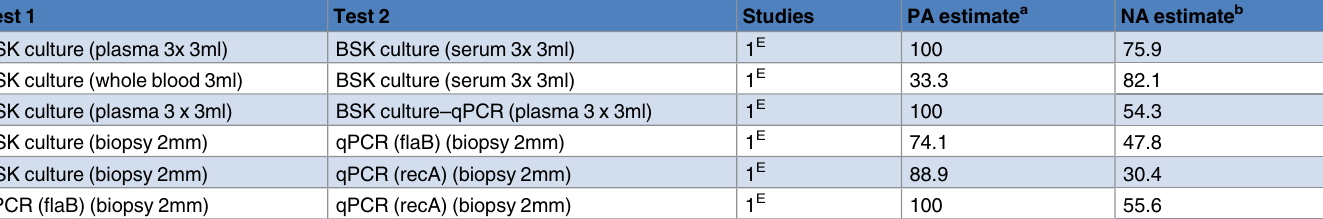
Table 7. Summaryof agreementreported in four studies (six lines of data) evaluating culture and/or PCR of biopsy and various blood samples for the identification of Borrelia spp. in early stage1 Lyme disease patients. Test